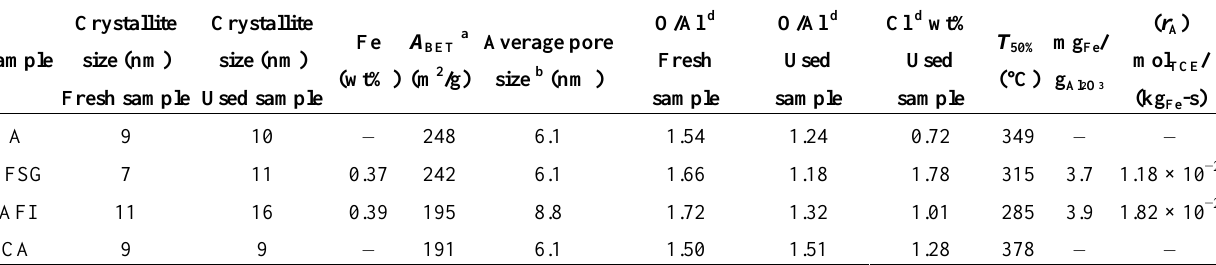
Table 1. Characteristics of the alumina